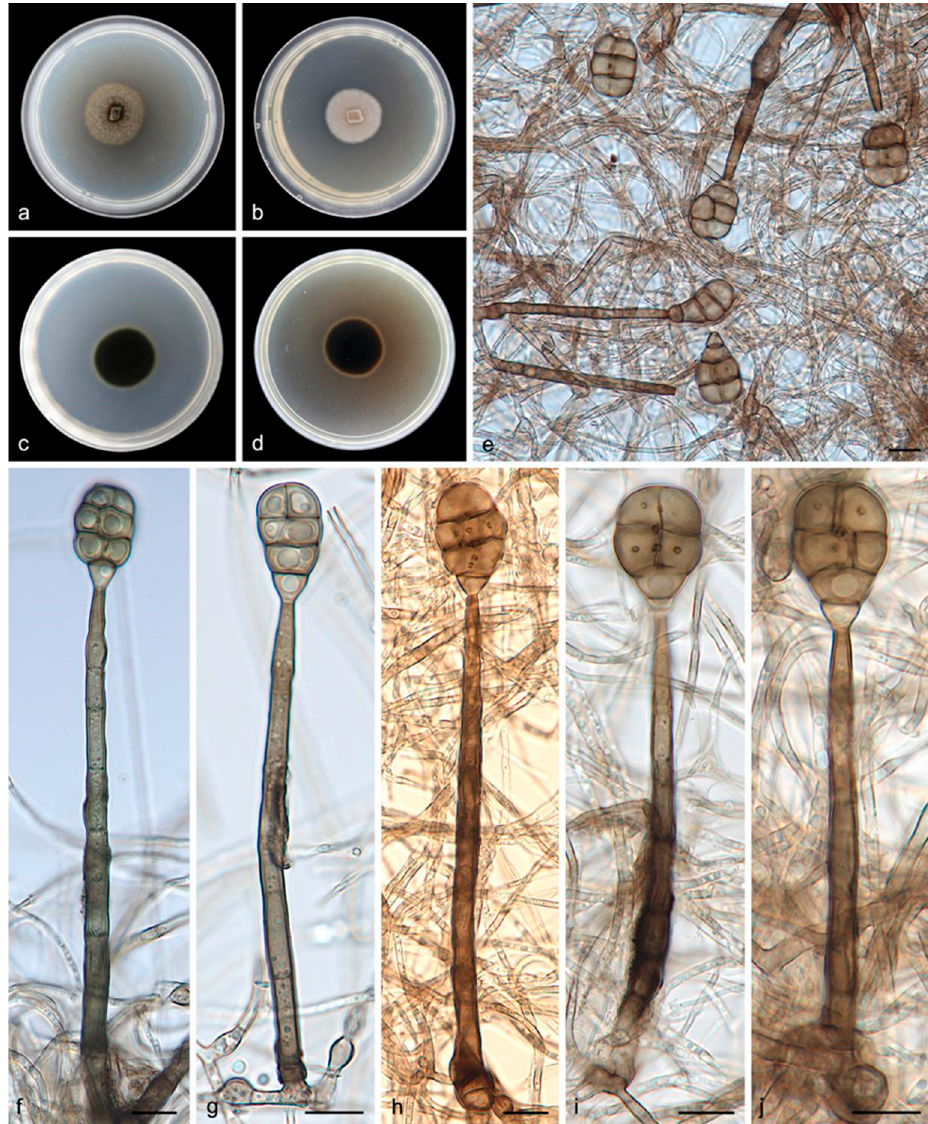
Figure 2. Acrodictys bawanglingensis ( holotype HMAS 352233, ex ‐ holotype SAUCC 1342 ): ( a , b ) surface sides of colony after incubation for 7 days on PDA ( a ) and MEA ( b );( c , d ) reverse sides of colony after incubation for 7 days on PDA ( c ) and MEA ( d ); ( e – j ) conidiophores, conidiogenous cells, and conidia. Petri dish diameter: 90 mm ( a – d ). Scale bars: 10 μ m ( e – j ).